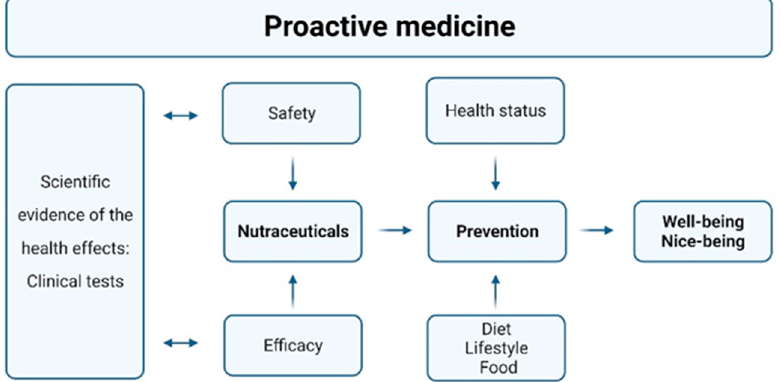
Figure 1. Proactive medicine nutraceutical approach (Created with “https://www.biorender.com (accessed on 12 December 2023)”.